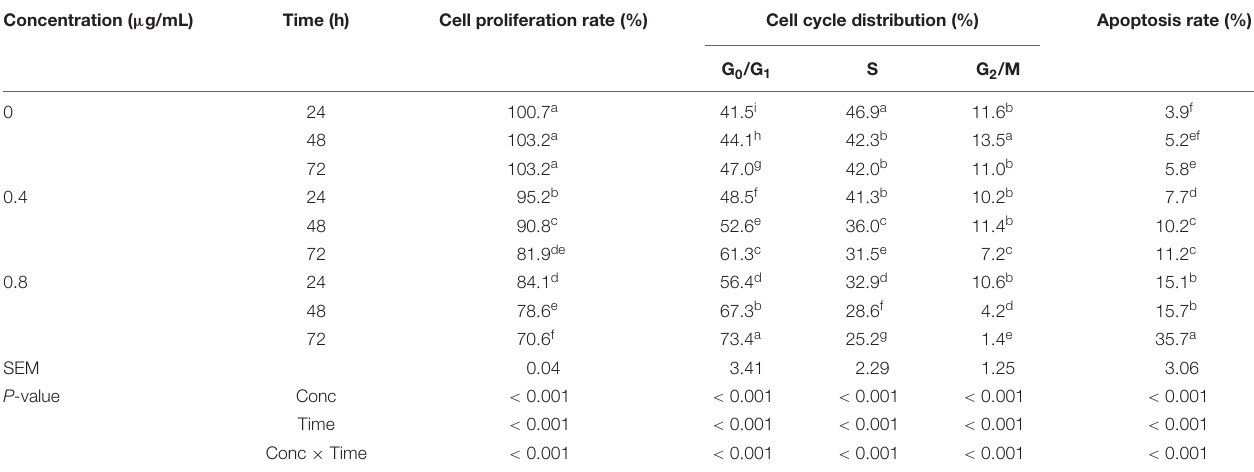
TABLE 4 | Effects of α -chaconine on the proliferation, cell cycle, and apoptosis of mouse intestinal epithelial cells. Concentration ( µ g/mL) Time (h) Cell proliferation rate (%) Cell cycle distribution